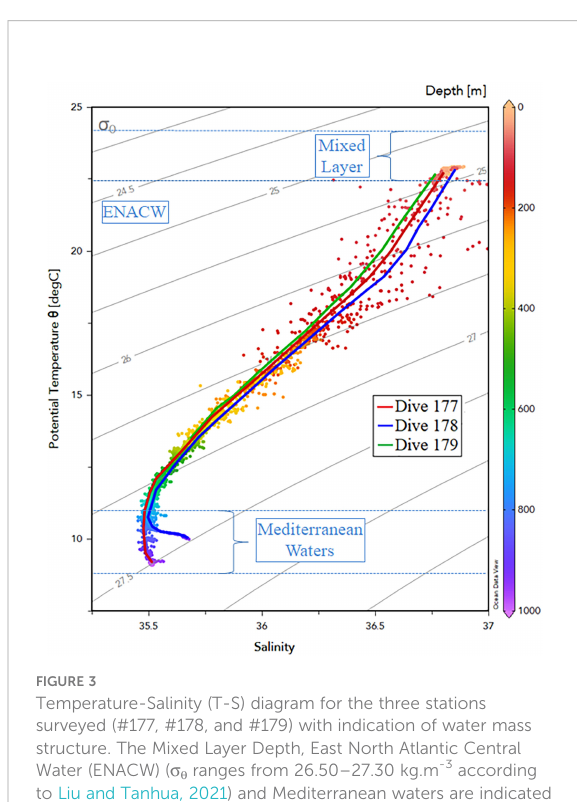
FIGURE 3 Temperature-Salinity (T-S) diagram for the three stations surveyed (#177, #178, and #179) with indication of water mass structure. The Mixed Layer Depth, East North Atlantic Central Water (ENACW) ( s q ranges from 26.50 – 27.30 kg.m -3 according to Liu and Tanhua, 2021) and Mediterranean waters are indicated within blue dashed